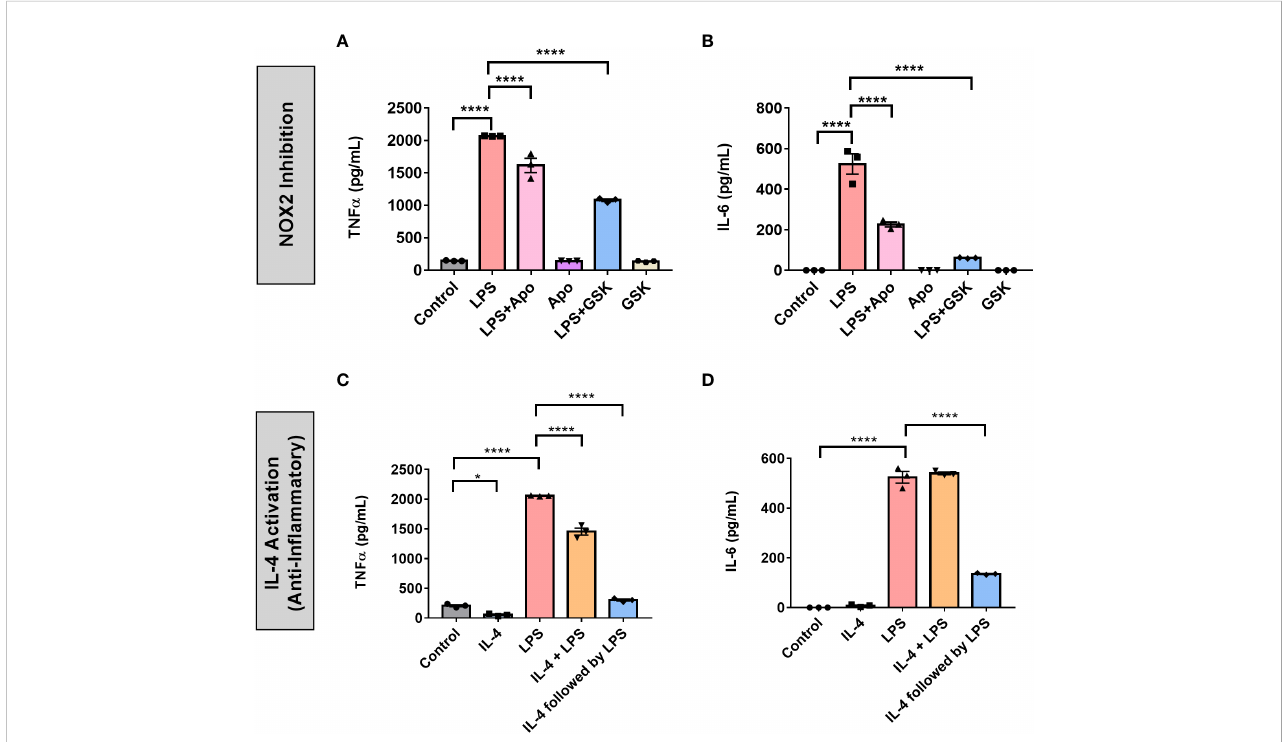
FIGURE 7 NOX2 inhibition in BV2 microglia creates an in fl ammatory environment similar to anti-in fl ammatory activation. (A) TNF- a and (B) IL-6 (pro-in fl ammatory cytokines) levels in BV2 cells (n = 3) with and without LPS and NOX2 inhibitors apocynin and GSK2795039 measured using ELISA. (C) TNF- a and (D) IL-6 (pro-in fl ammatory cytokines) levels in BV2 cells (n = 3) under IL-4 activation with and without LPS measured using ELISA. Data are represented as mean ± SEM and analyzed using single-factor ANOVA test. * denotes p < 0.05 and **** denotes p <